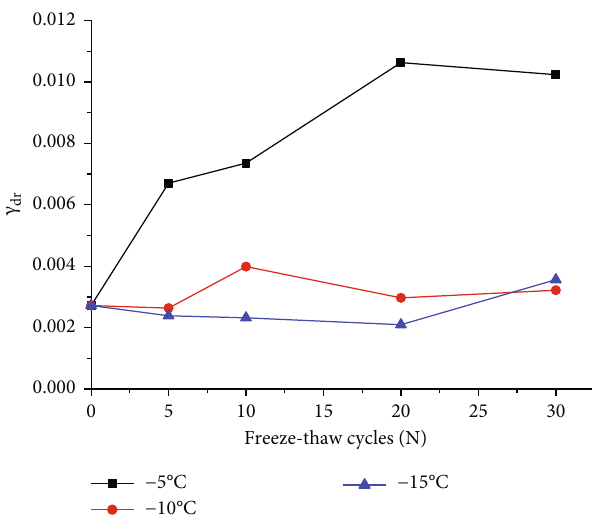
Figure 20: Curve of reference shear strain amplitude and freeze- thaw cycles at di ff erent freezing temperatures.